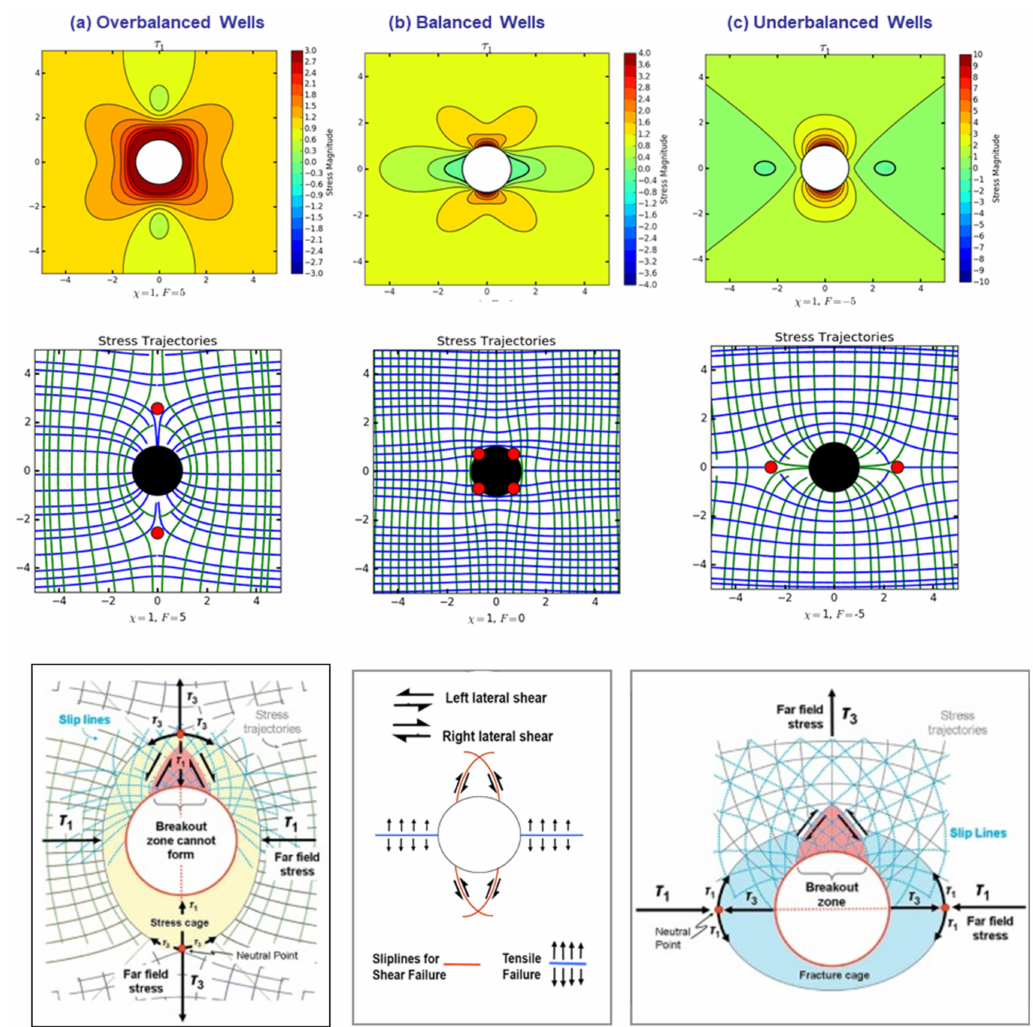
Figure 11. Stress magnitude contours ( top row), principal stress trajectories ( middle row), and slip lines for breakouts ( bottom row) for ( a ) overbalanced, ( b ) balanced, and ( c ) underbalanced wellbores. Red dots are neutral points. Blue trajectories are for the largest principal stresses (deviatoric compression τ 1 = σ 1 − P ). Green trajectories are for the smallest principal stresses (deviatoric tension, τ 3 = σ 3 − P ). The yellow ellipse on the bottom left outlines the stress cage. The blue ellipse on the bottom right outlines the fracture cage. The pink triangle shows the potential breakout region. Modified from Thomas and Weijermars